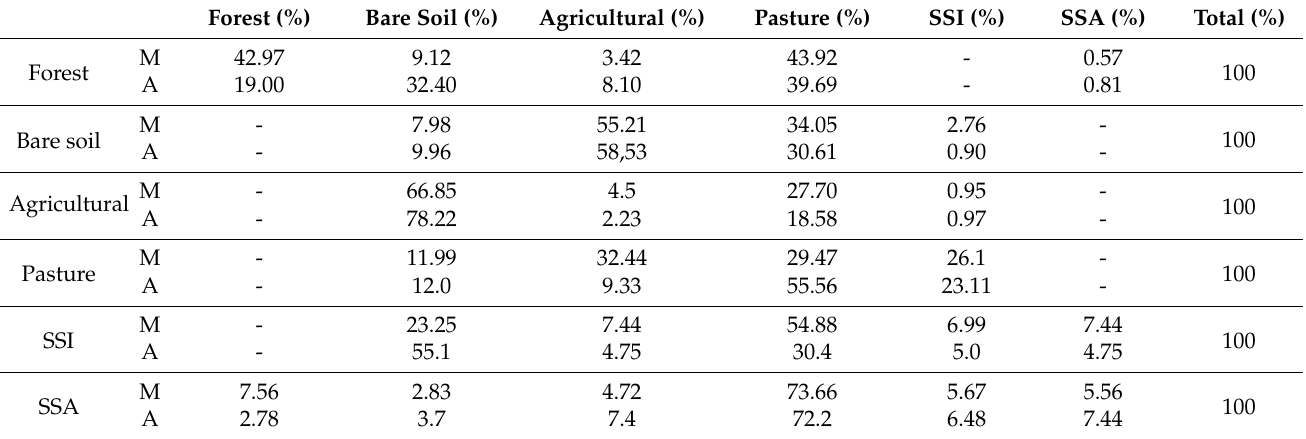
Table 4. Transition matrix for the fishbone (Anari settlement) and topographic or disorganized multidirectional (Machadinho settlement) models from 1984 to